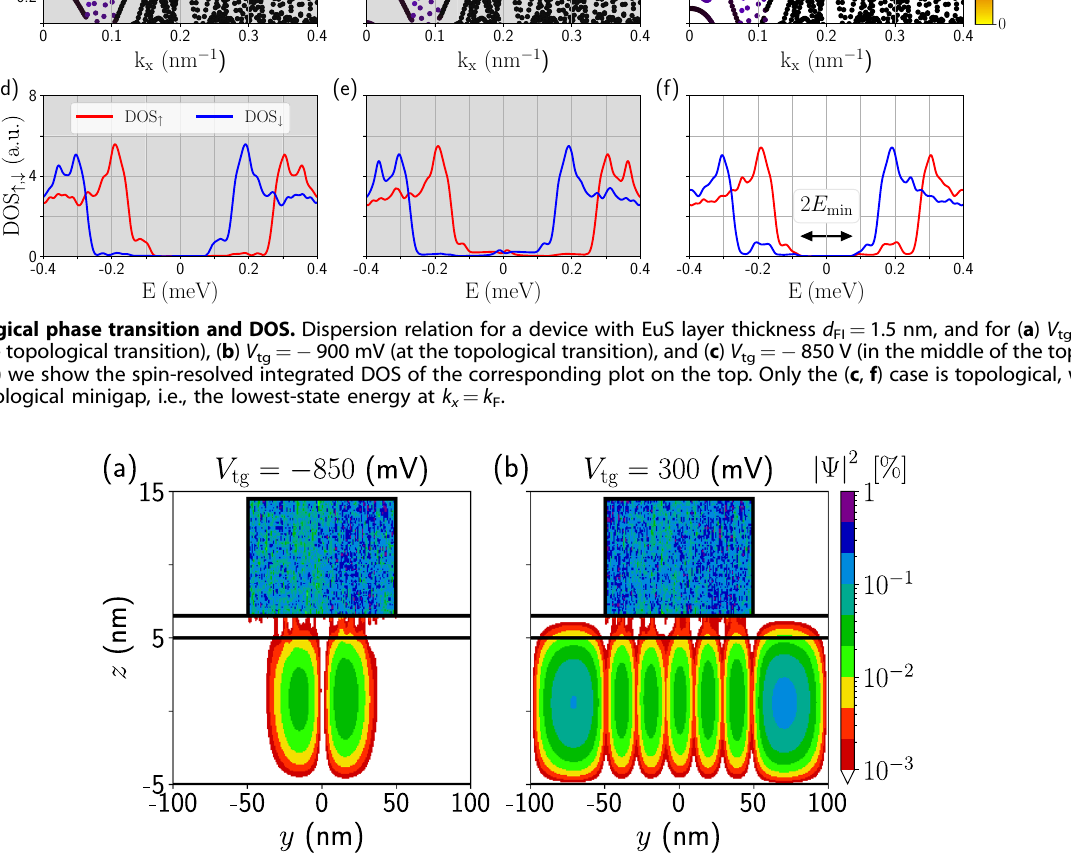
Fig. 4 Topological and trivial wavefunction pro fi les. a Transverse probability density at k x = 0 for the lowest-energy state in a topological regime ( V tg = − 850 mV). For comparison, we also show in ( b ) the case in a topologically trivial regime ( V tg = 300 mV). Parameters are the same as in Fig. 3, corresponding to d FI = 1.5 nm.